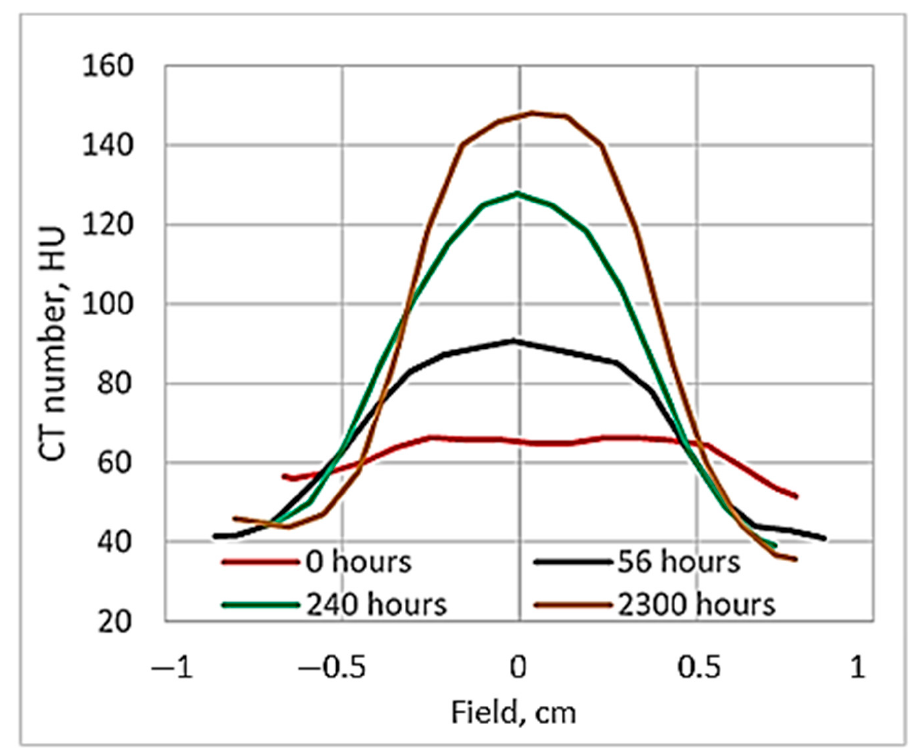
Figure 4. Comparison of 24 Gy irradiated gel dose profiles evaluated at different post-irradiation times.